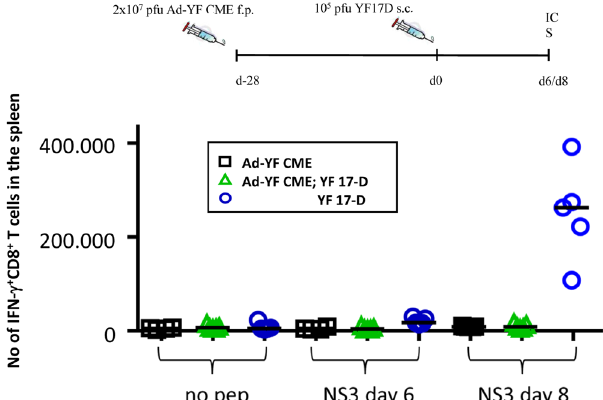
Figure 5. Pre-existing immunity to the YFV structural proteins (C,M,E) inhibits the CD8 + T cells response induced by YF-17D vaccination in mice. C57BL/6 (H-2b) mice were either untreated or vaccinated with an experimental adenoviral vectored vaccine, Ad-YF CME, directed against the structural proteins, core, membrane and envelope (C, M, E). Twenty-eight days later, all unvaccinated mice and half the vaccinated mice were s.c. immunized with the YF-17D vaccine, and the CD8 + T-cell response to the non-structural protein NS3 was determined. Following ex vivo peptide stimulation of splenocytes with NS3 268-275 , the number of CD44 + IFN- γ+ CD8 + T cells were determined 6 and 8 days post YFV infection using an intracellular cytokine staining (ICS); non-stimulated (no pep) cells served as controls. Symbols denote individual